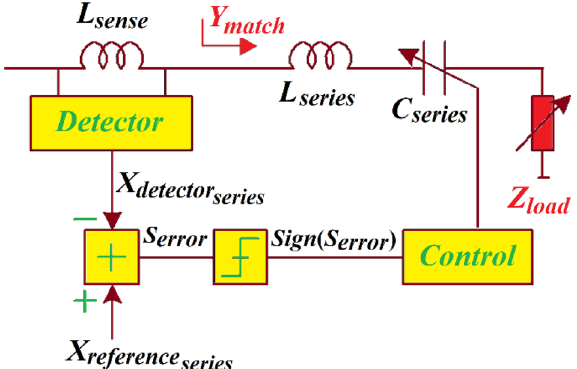
Figure 6. Series LC -network to control the real-part of the matched admittance G match .